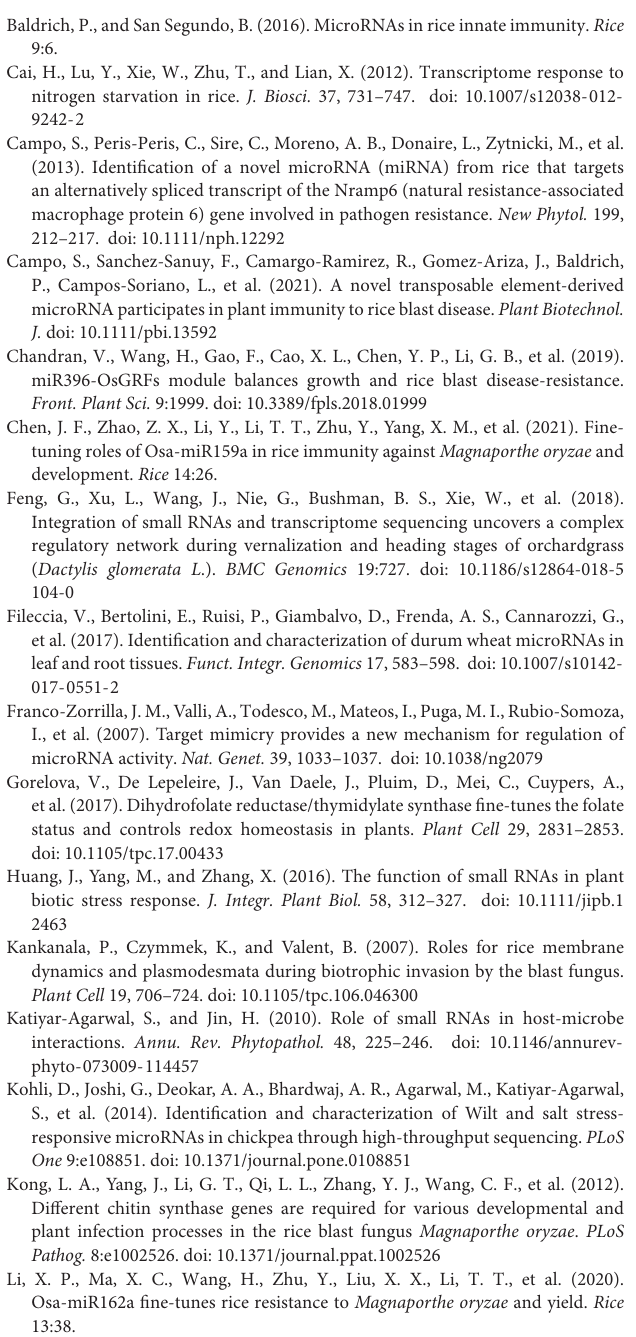
plant height of the indicated lines in (A) . The data are shown as mean ± SD ( n = 10 independent plants). Different letters above the bars indicate a significant difference ( P < 0.05) as determined by the one-way ANOVA analysis. Supplementary Table 1 | Primers used in this study. Supplementary Table 2 | Agronomic traits of the Kasalath control and the transgenic